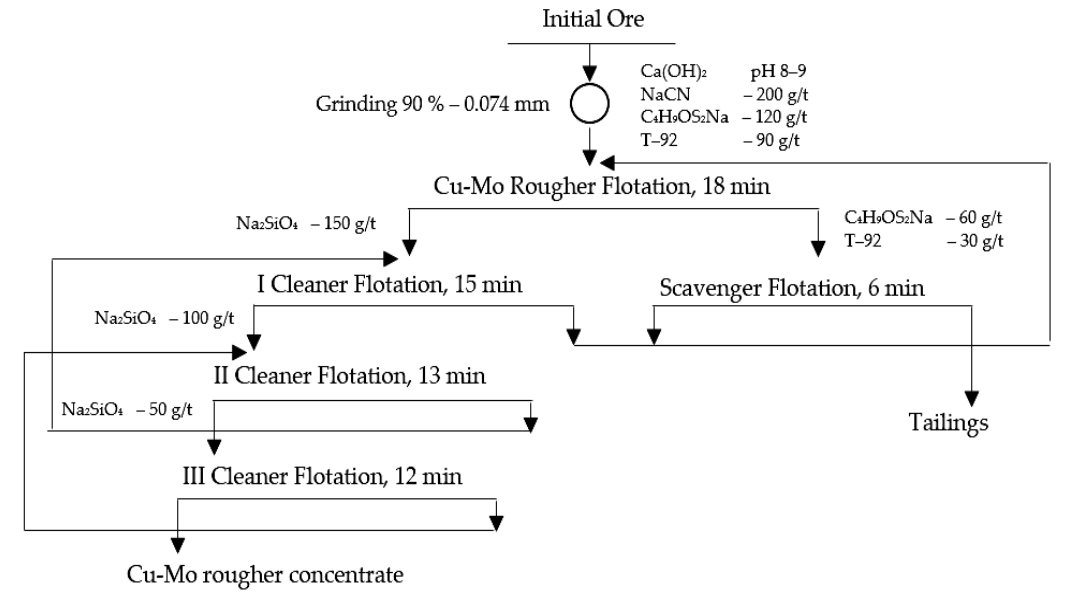
Figure 2. Scheme of copper-molybdenum rougher flotation of ore.